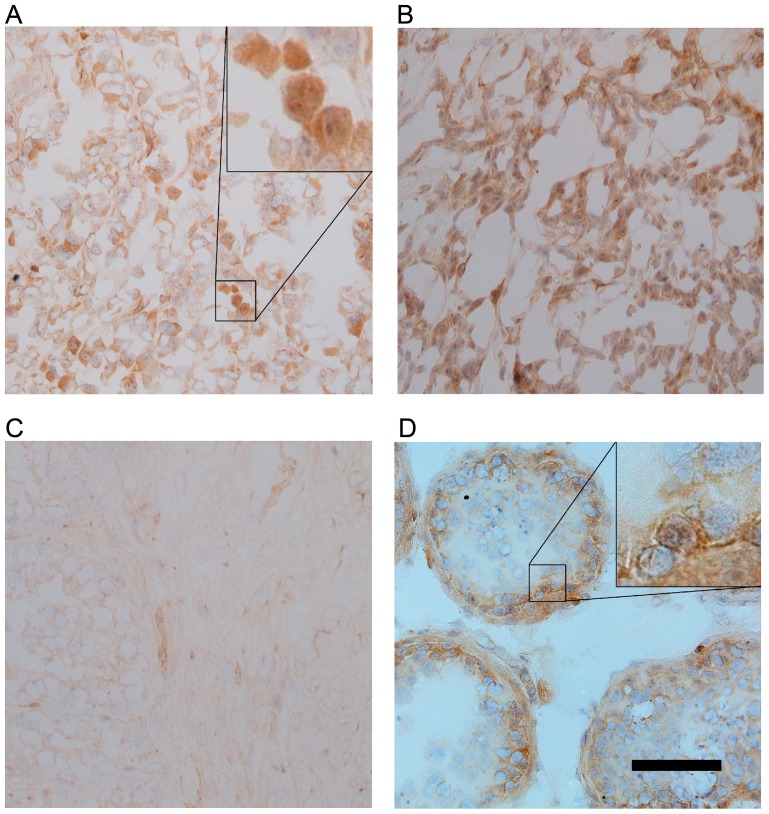
CT16 location in frozen tissue samples.CT16 was detected in the tissue samples with CT16-specific antibody visualized by Vectastain ABC kit and diaminobenzidine, and the sections were counterstained with hematoxylin. (A, B) Melanoma skin metastasis samples from two patients. (C) Primary prostate cancer (negative control). (D) Testis sample (positive control). Both cytoplasmic and nuclear CT16-specific staining is visible in the magnified area (inset) of the melanoma skin metastasis sample. In the testis sample the magnification shows CT16-specific staining of spermatogonia. The scale bar in the testis image represents the magnification as 150 µm for all images.